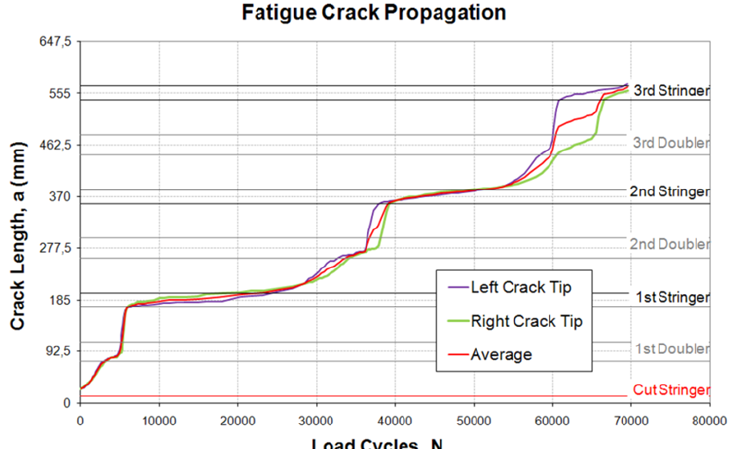
Figure 6: Experimental FCP curve illustration of left and right crack length and their average values (two bays-cracked panel).